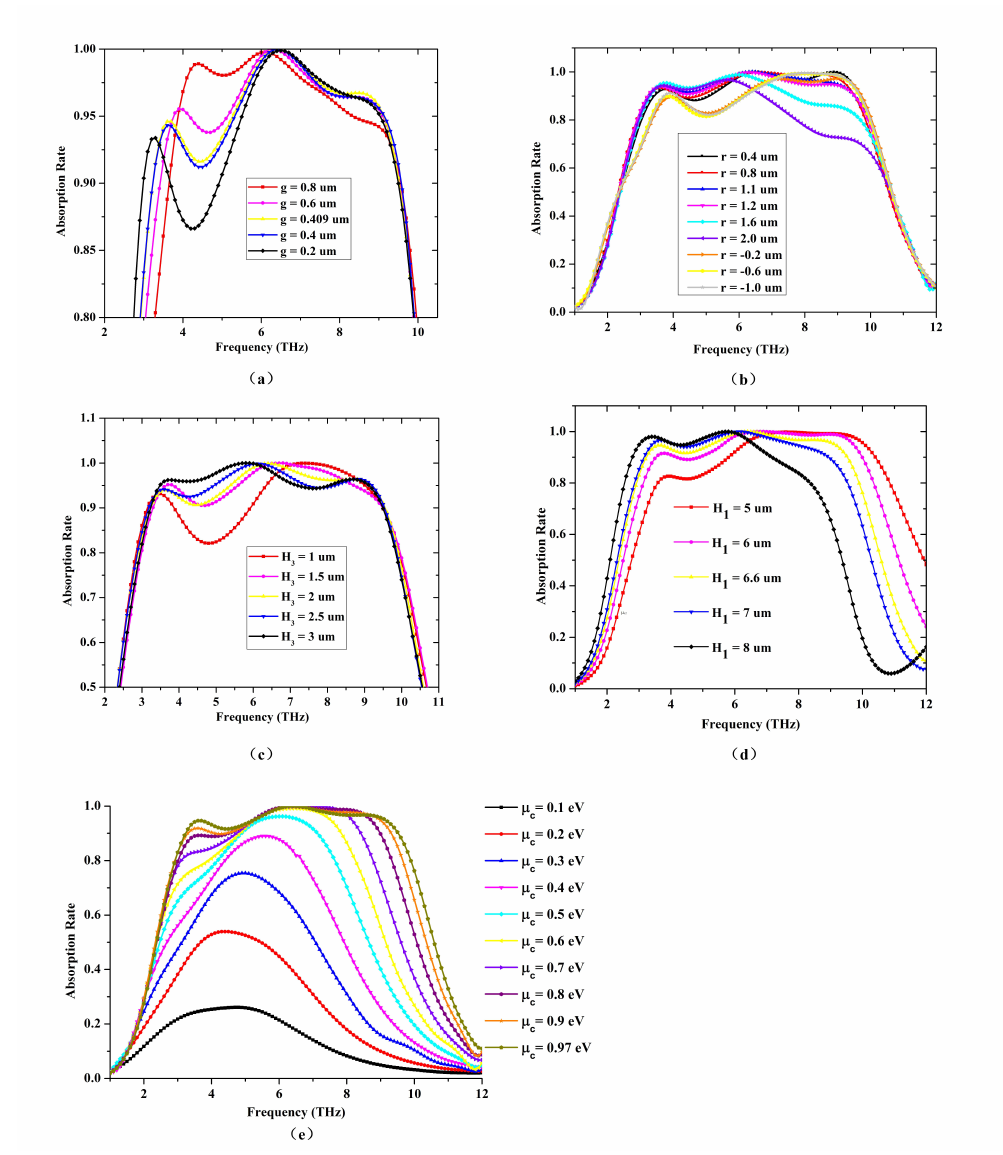
Figure 7. The simulated absorption rate with the change of ( a ) g, ( b ) r, ( c ) H 3 , ( d ) H 1 and ( e ) the Fermi level µ c